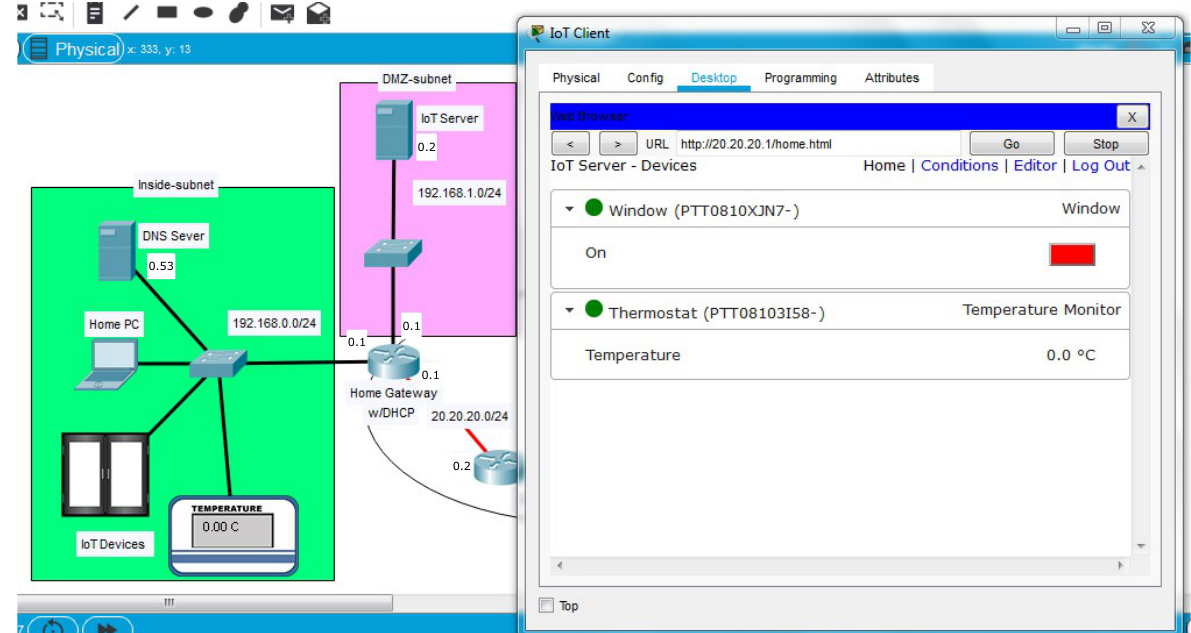
Figure 12. Monitoring the status of a IoT device from a IoT client.